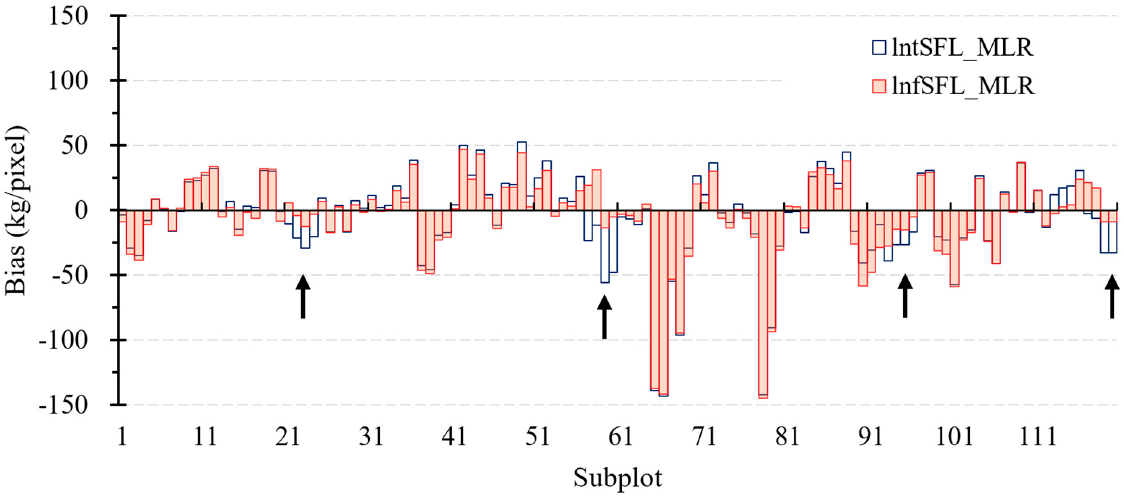
Figure 7. Prediction bias of surface fuel loadings in the lnfSFL–BioTopo and lntSFL–BioTopo models. The x –axis represents the identity of inventory samples, and the y –axis is the bias determined by the difference between estimated and inventory data. A negative value indicates an underestimation while a positive value represents an overestimation. The arrow below the hollow bars indicates that the corresponding inventory subplots (identity number: 21–24/57–60/93–96/119–120) had a significant FDW mass as well as a larger estimation bias in the tSFL estimates.